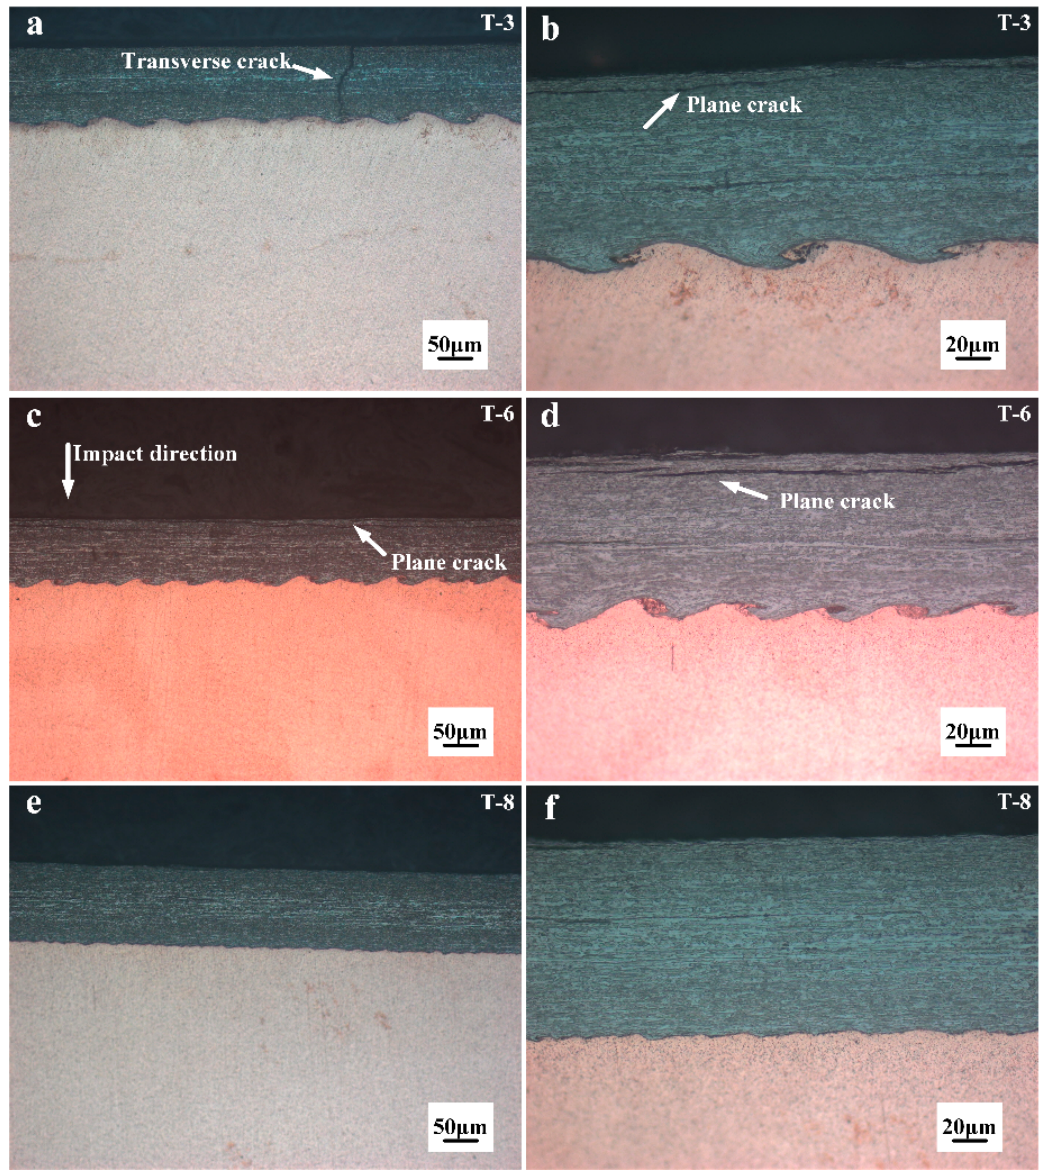
Figure 5. Comparison of interfacial morphologies among different samples: ( a , b ) T-3; ( c , d ) T-6; ( e , f ) T-8.